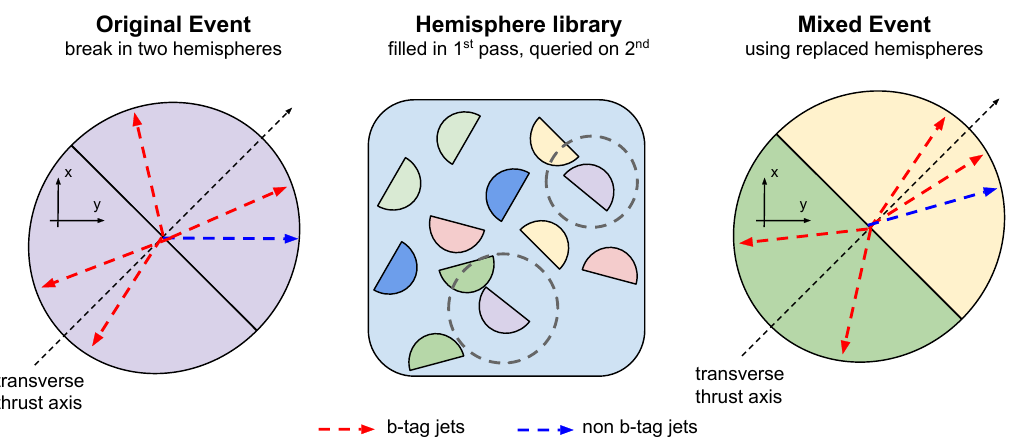
Figure 2 . An illustration of the hemisphere mixing procedure. The transverse thrust axis is de(cid:12)ned as the axis on which the sum of the absolute values of the projections of the p T of the jets is maximal. Once the thrust axis is identi(cid:12)ed, the event is divided into two halves by cutting along the axis perpendicular to the transverse thrust axis. One such half is called a hemisphere ( h ). In a preliminary step, each event in the original N -event data set is split into two hemispheres that are collected in a library of 2 N hemispheres. Once the library is created, each event is used as a basis for creating arti(cid:12)cial events. These are constructed by picking two hemispheres from the library that are similar to the two hemispheres that make up the original